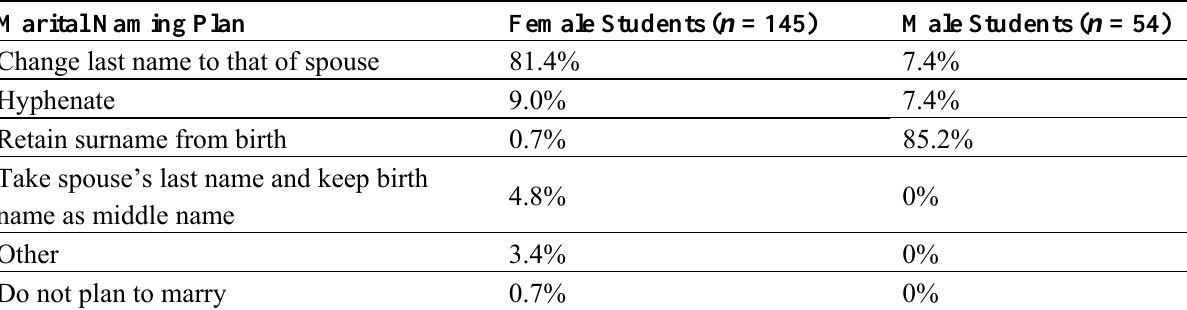
Table 1. Marital Naming Plans of